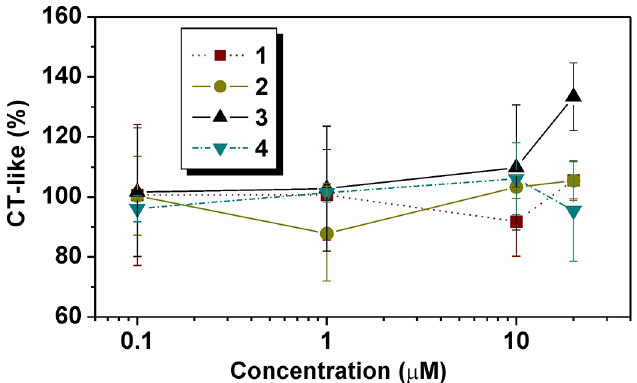
Fig 6. The results (CT-like activity (% ± SD) of the studies of the ability of the complexes 1 – 4 to inhibit 20S proteasome activity assayed in purified proteasome obtained from A2780 cancer cell line